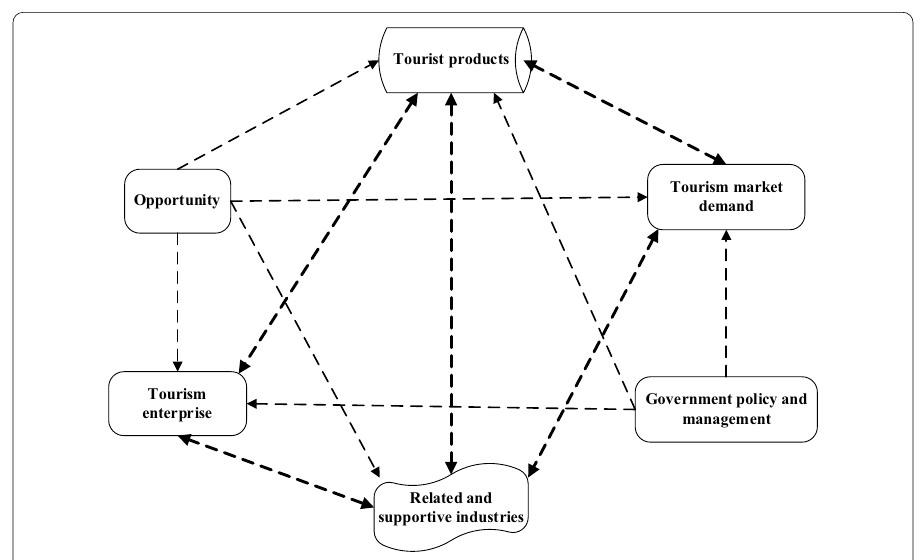
Fig. 1 Tourism industry competitiveness “diamond